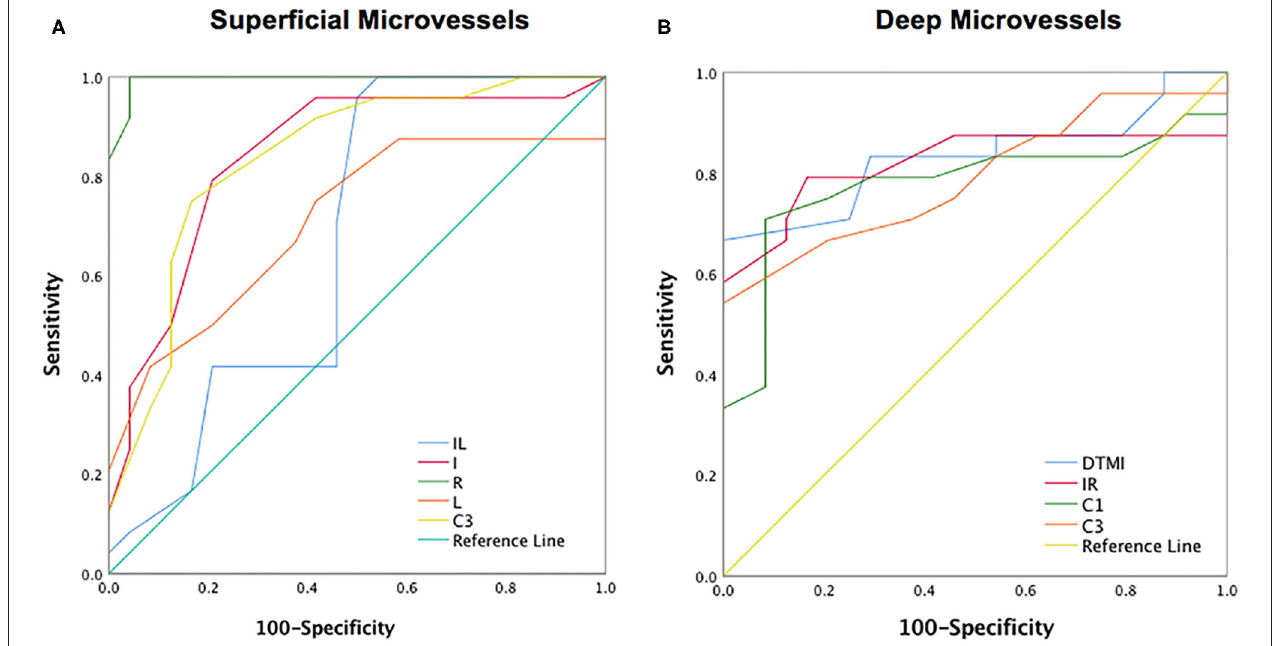
FIGURE 5 | ROC curve analysis of sectorial, quadrantal and annular microvascular densities of retinal layer. (A) The ROC curve analysis of superficial retinal layer; (B) The ROC curve analysis of deep retinal layer. I, inferior; IL, inferior left; IR, inferior right; L, left; R, right; DTMI, Deeper total microvascular.